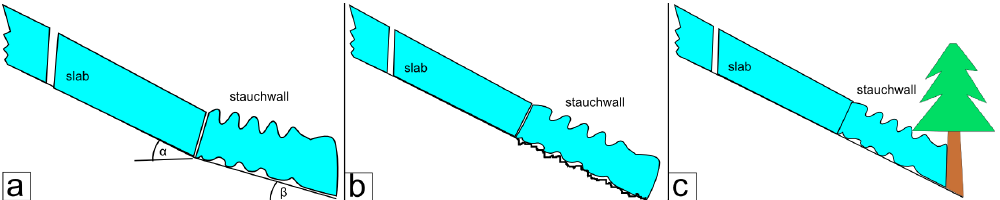
Figure 5. Cases where a stauchwall forms: in (a) , the area below the release zone is flatter than the release area. The rougher surface below the release zone fixes snow to the ground (b) , and a tree can be an effective obstacle stabilizing the snow cover below the release area (c)